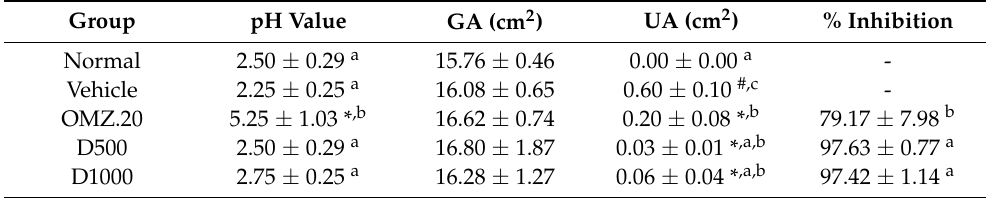
Table 4. Effect of Phy-Blica-D on gastric lesions induced by 80% ethanol in rats.